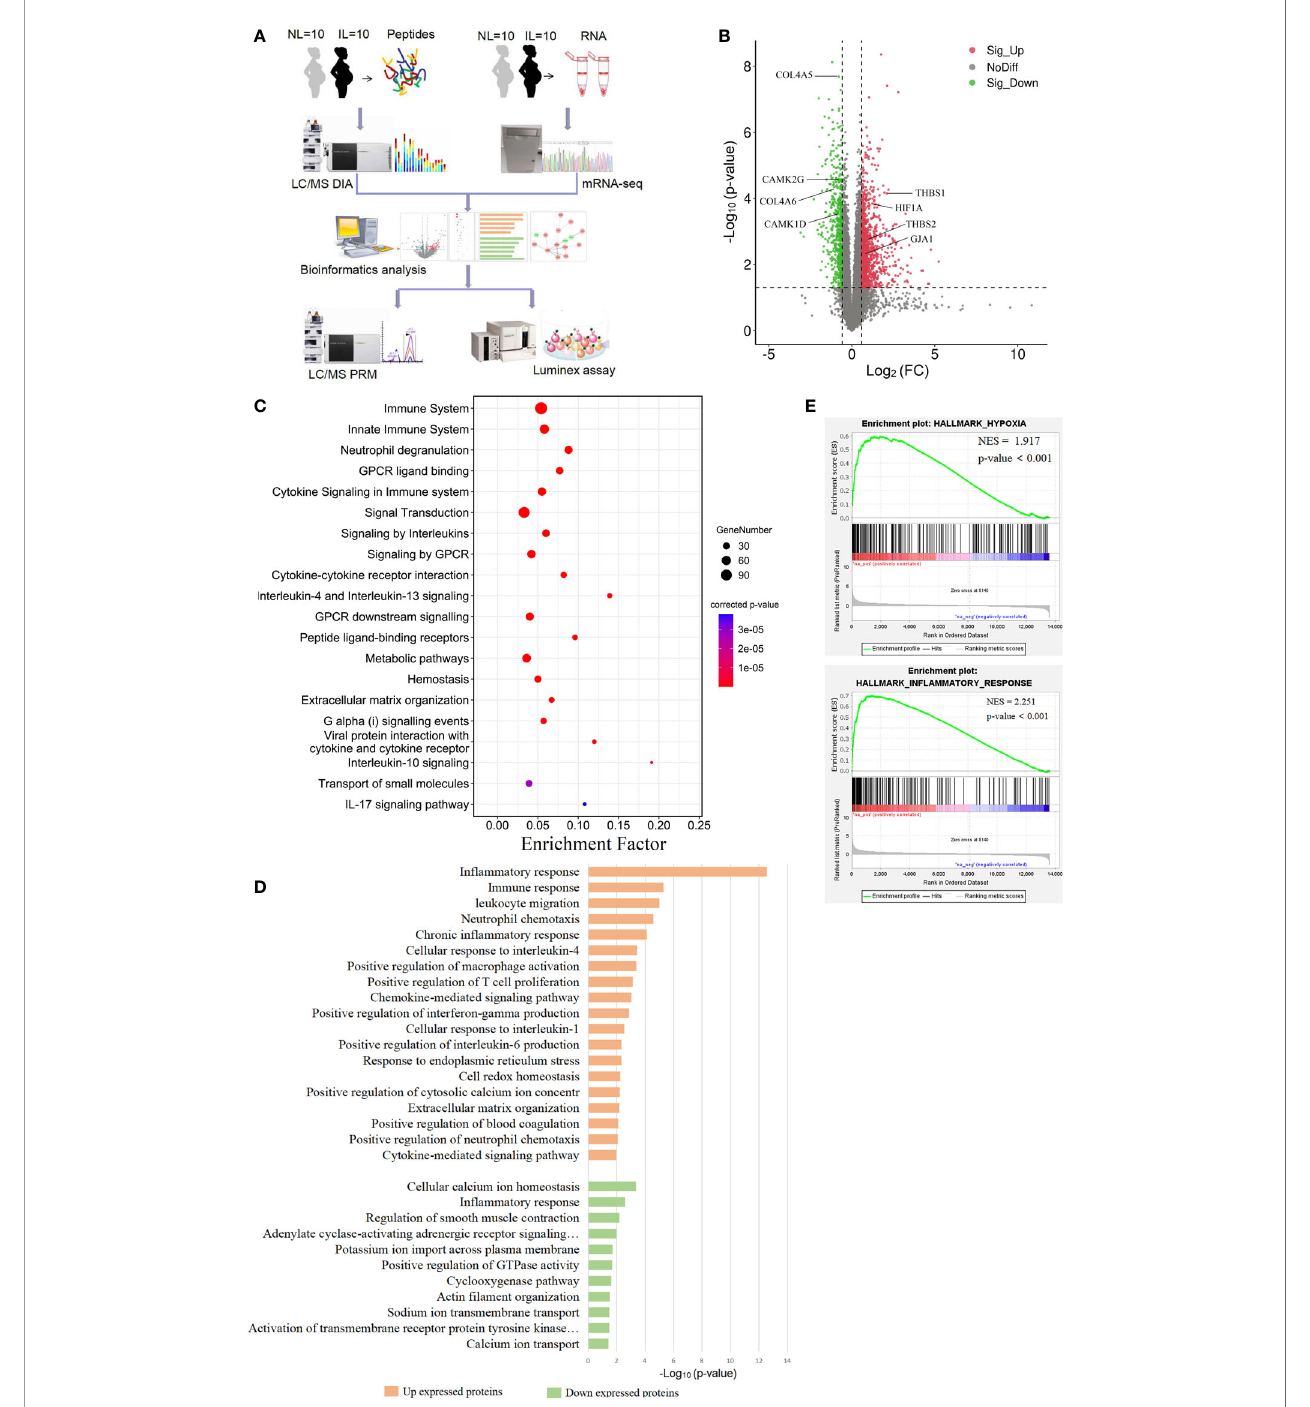
FIGURE 1 | Visualization of the transcriptomics results of mRNAs between nonlabor and in labor myometrium. (A) Overall study design and work fl ow. (B) Volcano plot of all mRNA alteration between NL and IL groups. The horizontal dashed line corresponds to p value < 0.05, and the vertical dashed line corresponds to a 1.5- fold change decrease or increase in expression levels. Red, green, and black dots represent upregulated, downregulated, and nondifferentially expressed transcripts in the IL group (as compared to the NL group), respectively. Data associated with this fi gure can be found in Supplemental Table 1 . (C) Bubble diagram of partial signi fi cantly enriched pathways for DE mRNAs. (D) Bar diagram of partial biology progress GO term clusters of DE mRNAs. (E) GSEA plots of mRNA sets of hypoxia and in fl ammatory